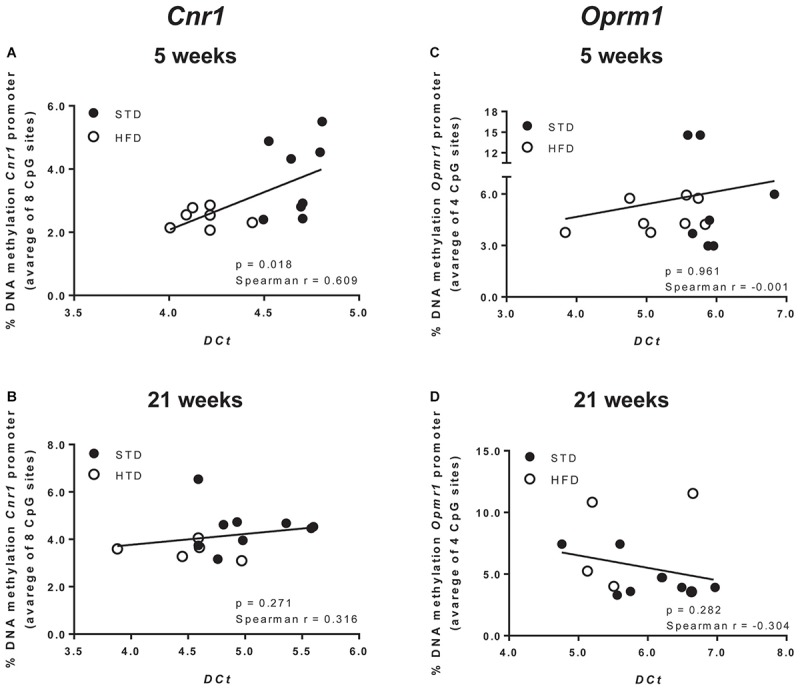
Correlation between Cnr1 expression and % change of DNA methylation after 5 (A) and 21 weeks of diet (B). Correlation between Oprm1 expression and % change of DNA methylation after 5 (C) and 21 weeks of diet (D). Data were analyzed by Spearman’s rank correlation coefficient.